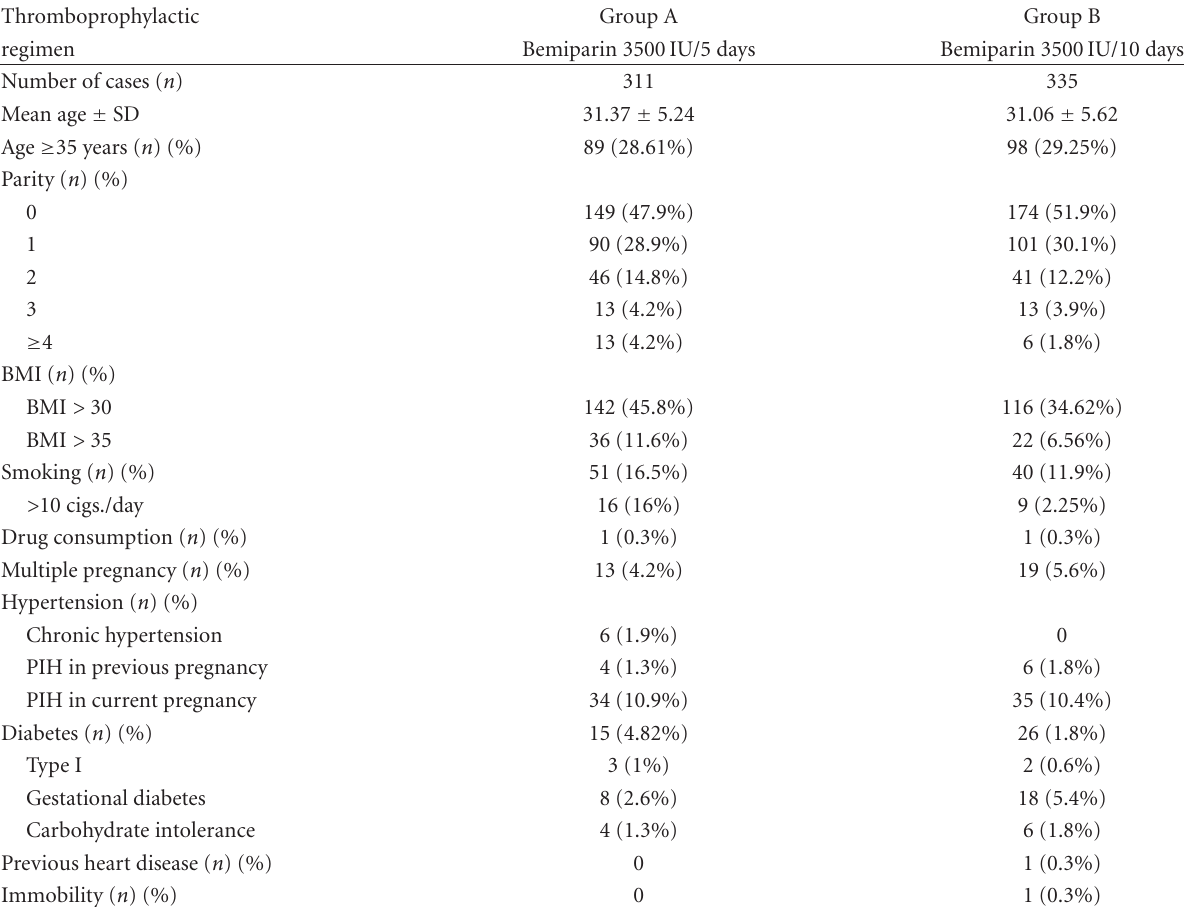
Table 1: Characteristics of patients in the study groups and predelivery thrombosis risk